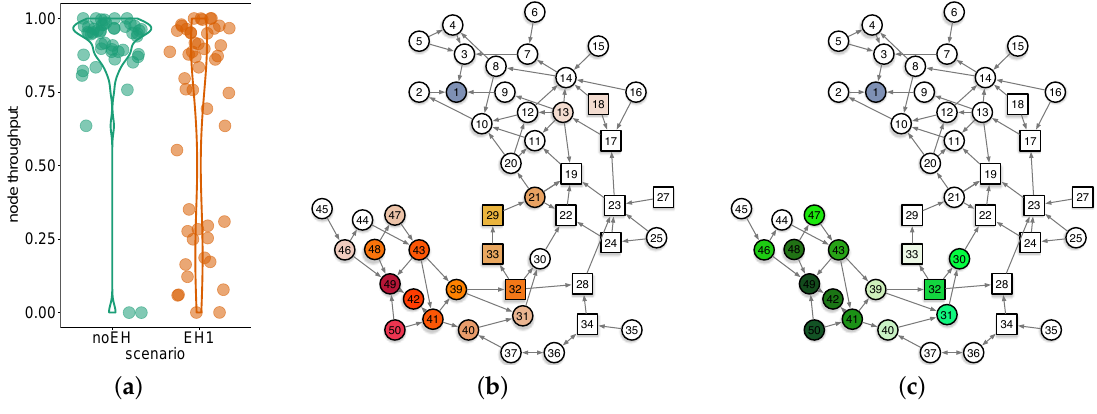
Figure 8. Performance and snapshots of CTP under deployment EH1. In sub-figures ( b , c ), square nodes represent EH-nodes (others are normal nodes), node of number one is the sink, the color intensity of a node represent the relative measurements at that node, and the arrows are the directional links being used by CTP when this snapshot is recorded. ( a ) node throughput; ( b ) #parent updates/EH1; ( c ) #loop